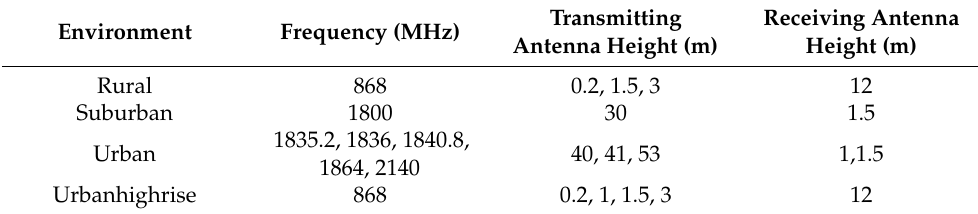
Table 1. Dataset